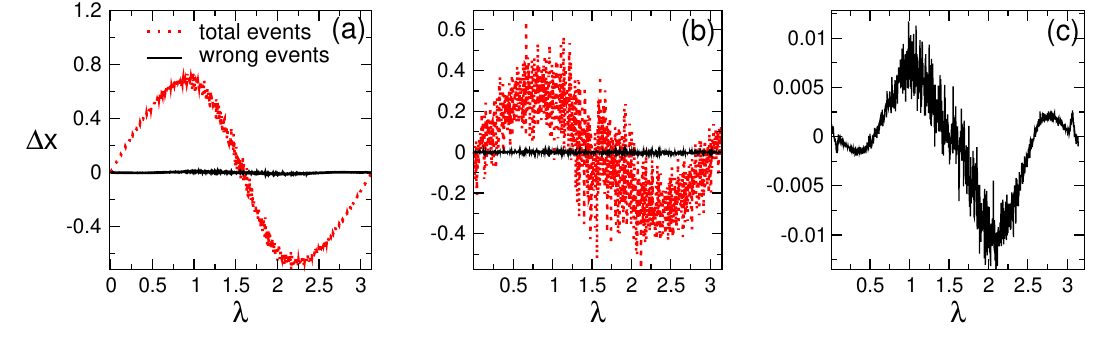
Figure 6: Effect of the “wrong” scattering events on the quasiparticles trajectories. We show the shift ∆ x experienced by the quasiparticles with rapidity λ due to scatterings with other particles. The data are for the initial thermal density matrix in (31) with β = 0.5 and β h = 0.25. (a) shows ∆ x due to all the scatterings (dotted line) and only to the wrong scattering events (continuous line) for the unbound particles. In (b) we show the result for the two-particle bound states. Panel (c) shows the shift due to the wrong collisions for the unbound particles (same data as in